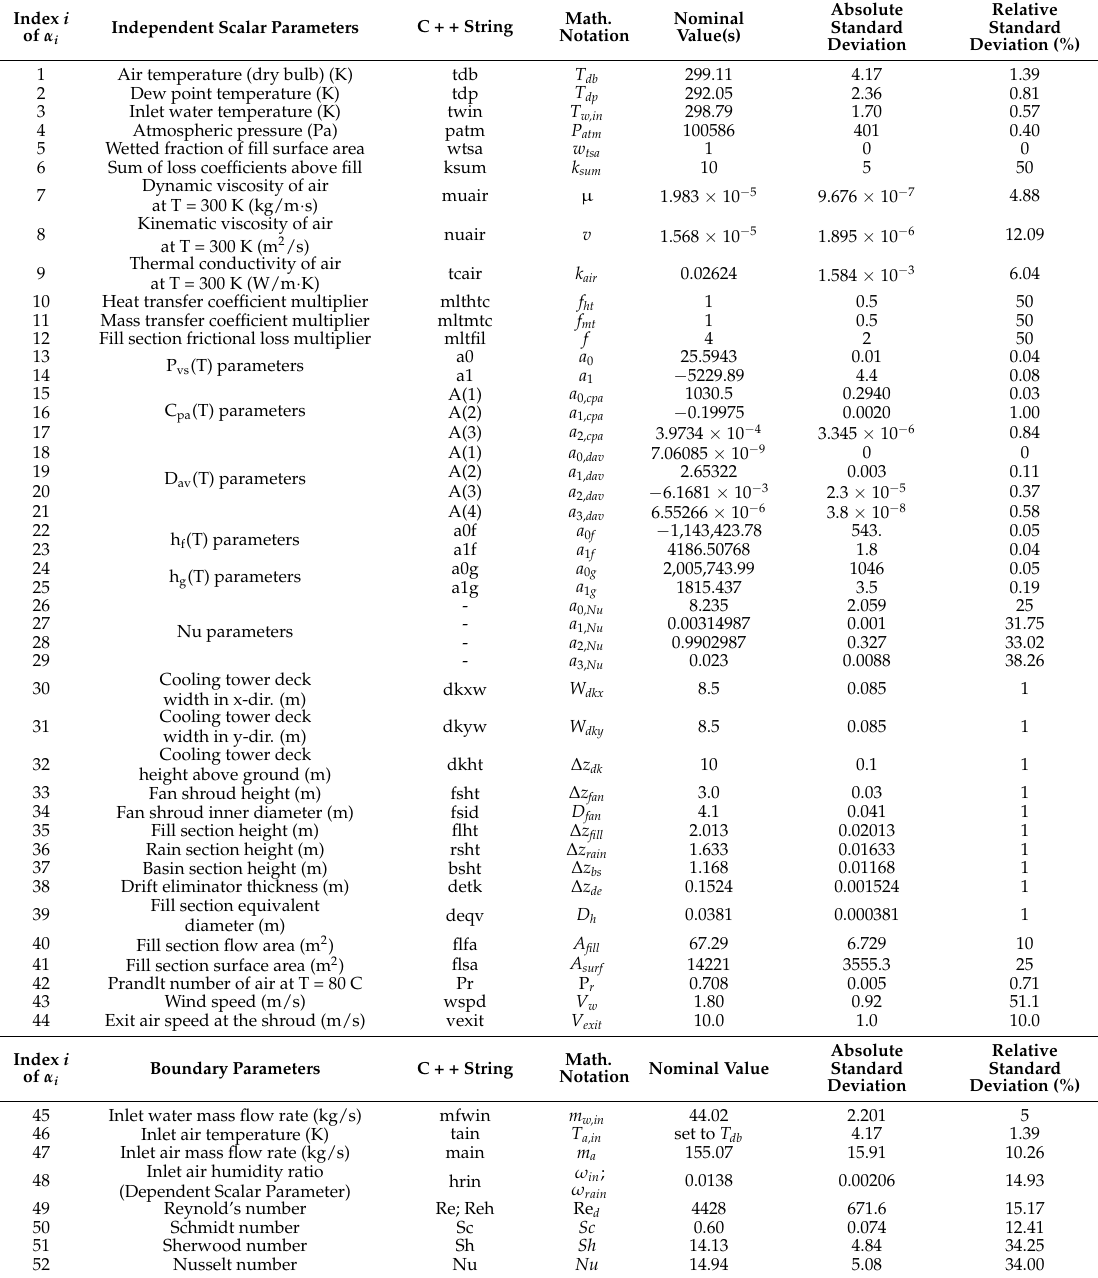
Table A1. Parameters for SRNL f-area cooling